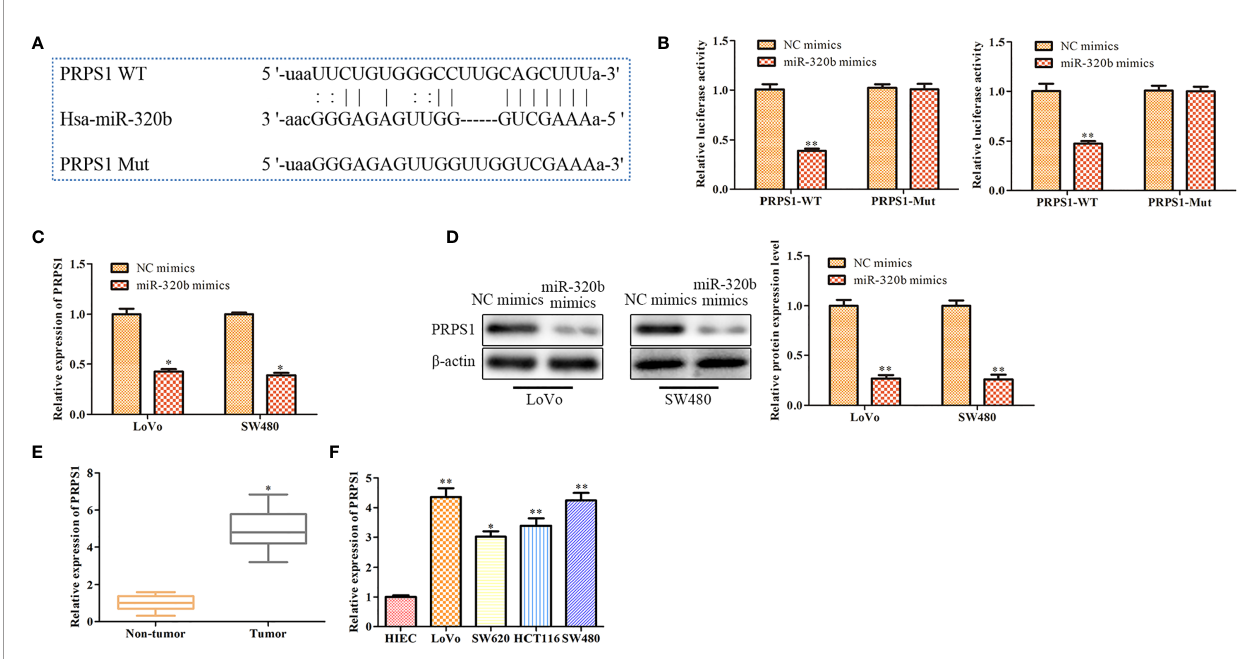
FIGURE 6 | PRPS1 is a target gene of miR-320b. (A) PRPS1 was predicted as a target of miR-320b via bioinformatics analysis. (B) miR-320b was bound to 3 ’ UTR of PRPS1 using dual luciferase reporter assay, ** P < 0.01 vs . NC mimics. (C) The level of PRPS1 was determined by qRT-PCR, * P < 0.05 vs . NC mimics. (D) The level of PRPS1 was determined by Western blot, ** P < 0.01 vs . NC mimics. (E) The relative expression of PRPS1 was determined by qRT-PCR in non-tumor and CRC tissues, * P < 0.05 vs . non-tumor tissues. (F) The relative expression of PRPS1 was determined by qRT-PCR in CRC cell lines, * P < 0.05, ** P < 0.01 vs .